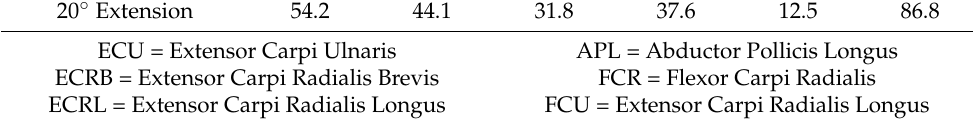
Table 1. Forces applied to the tendons of the two models during the two conditions of extension and radial extension [28]. Note that the total force applied for each wrist position is 267 N. Tendon Force [N] Wrist position